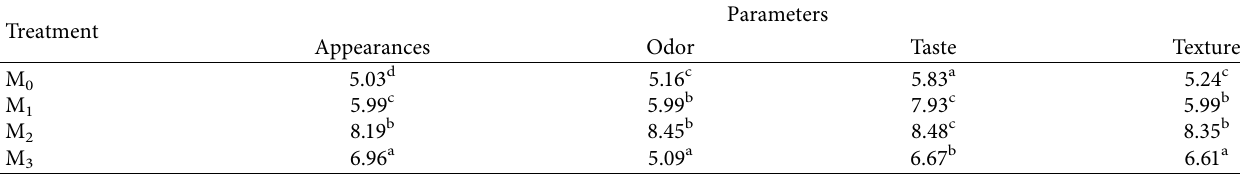
Table 2: The average organoleptic value of fortified sago noodles from fish meal.